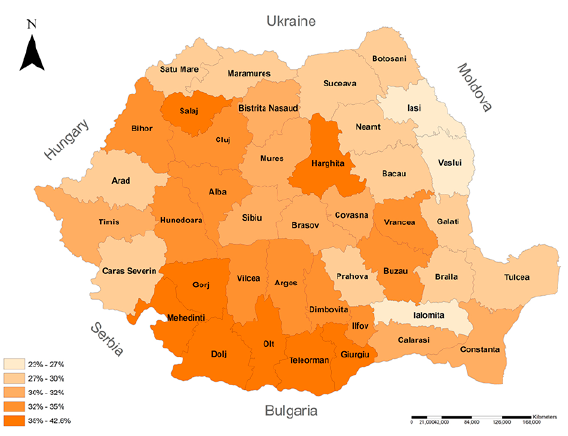
Figure 1. Turnout at the Romanian parliamentary